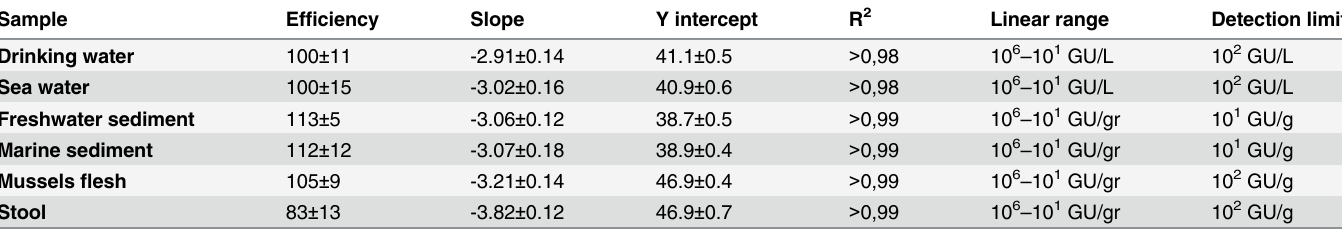
Table 2. Amplification parameters for the qPCR assay applied to environmental and stool